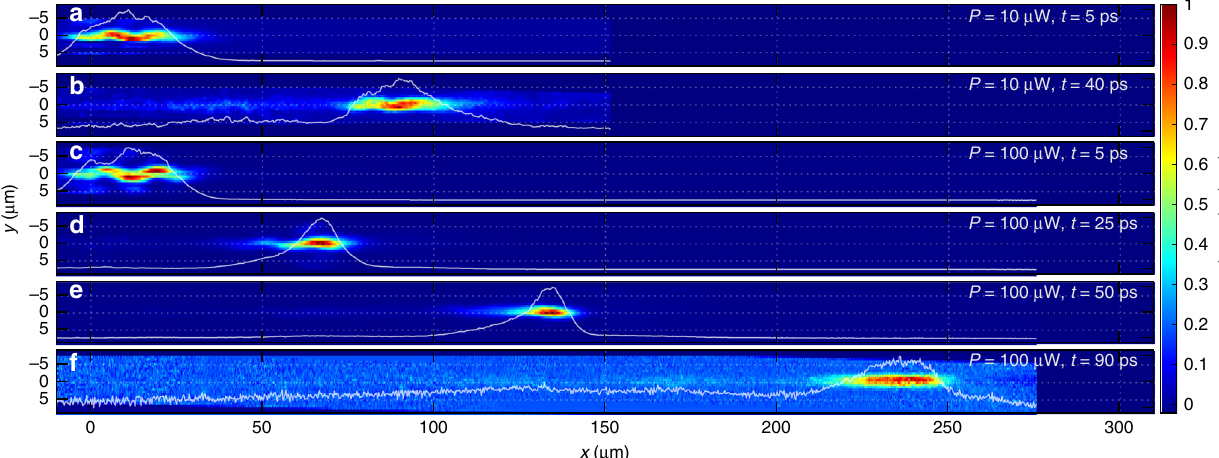
Fig. 5 Experimental observations of real-space evolution in time. a , b Images of the polariton pulse at different times (5 and 40 ps, respectively) with the low excitation power P = 10 μ W. c – f Images of the polariton pulse (excitation beam P = 100 μ W) showing the soliton compression effect ( d , e ) followed by the expansion ( f ) captured at 5 ps ( c ), 25 ps ( d ), 50 ps ( e ) and 90 ps ( f ). All images are reconstructed from tomographic scans performed using the streak camera. Time t = 0 corresponds to the arrival of the excitation pulse. White lines show the normalised intensity pro fi les integrated over y